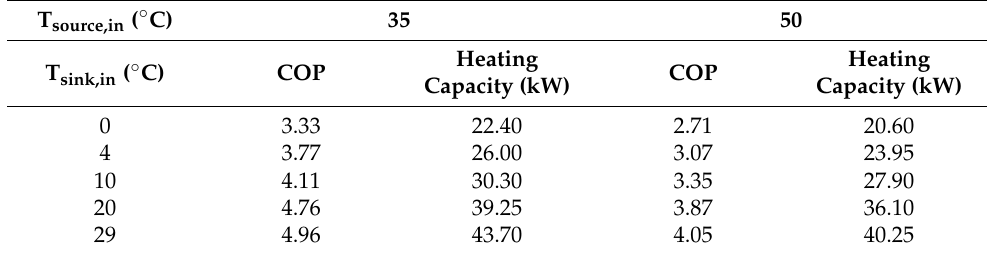
Table 4. COP and heating capacity for evaporator and condenser inlet